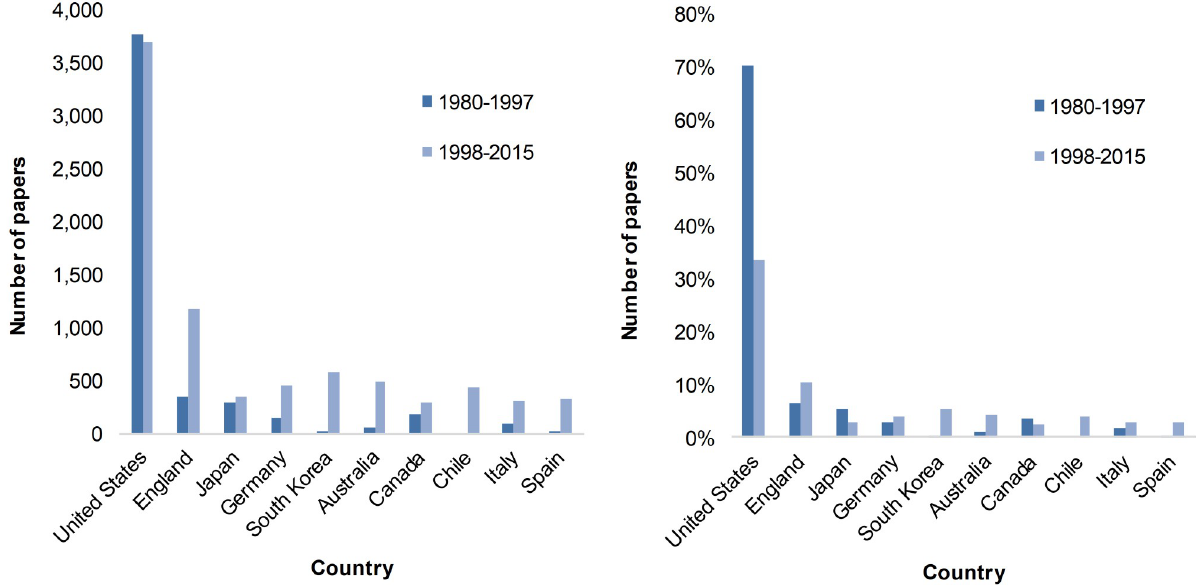
Fig 3. Number (left) and proportion (right) of scholarly/academic papers by country (top 10), 1980–1997 and 1998–2015.